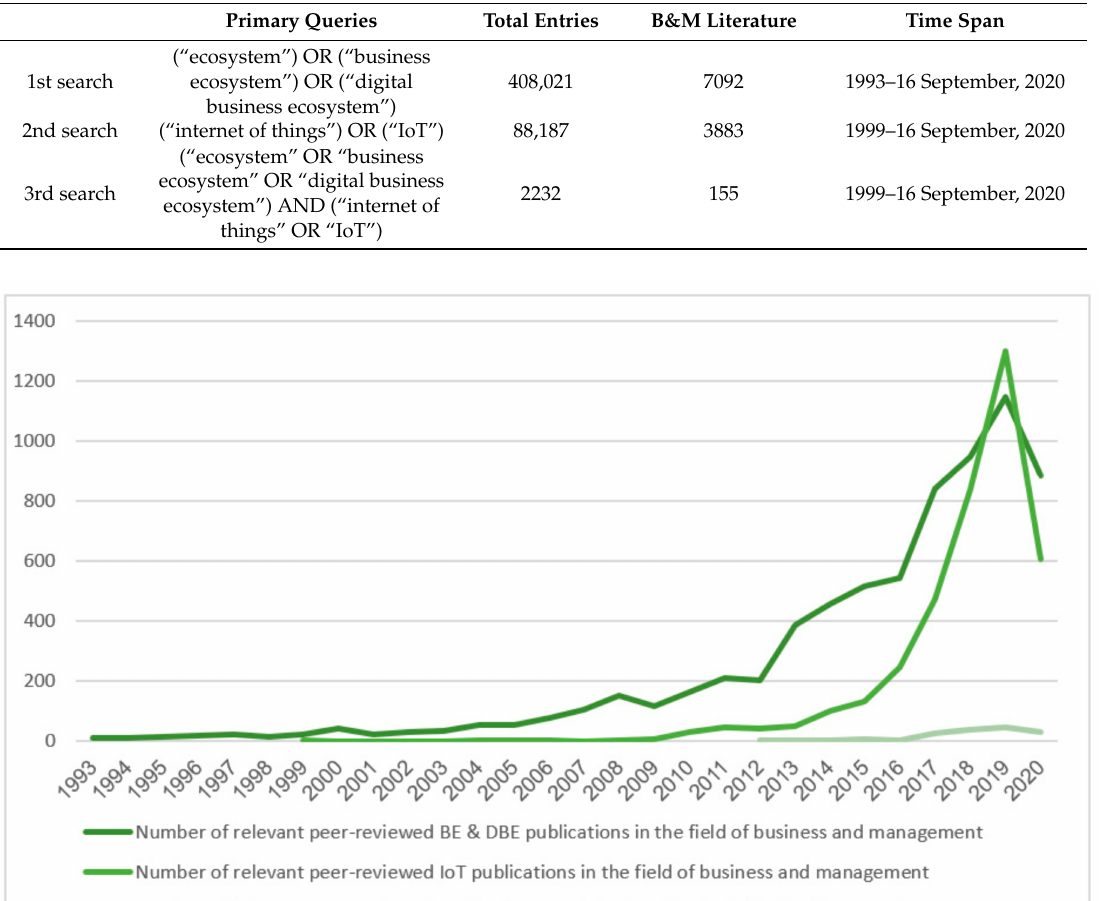
Table 3. Overview of literature review searches.